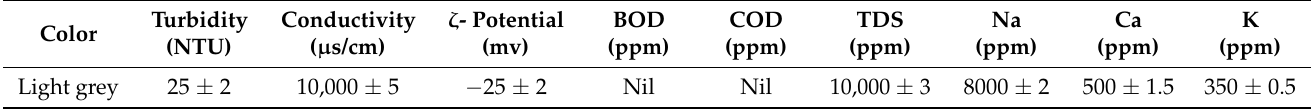
Table 1. The characteristics of the underground brackish water (pH = 8 at T ◦ C = 24). Color